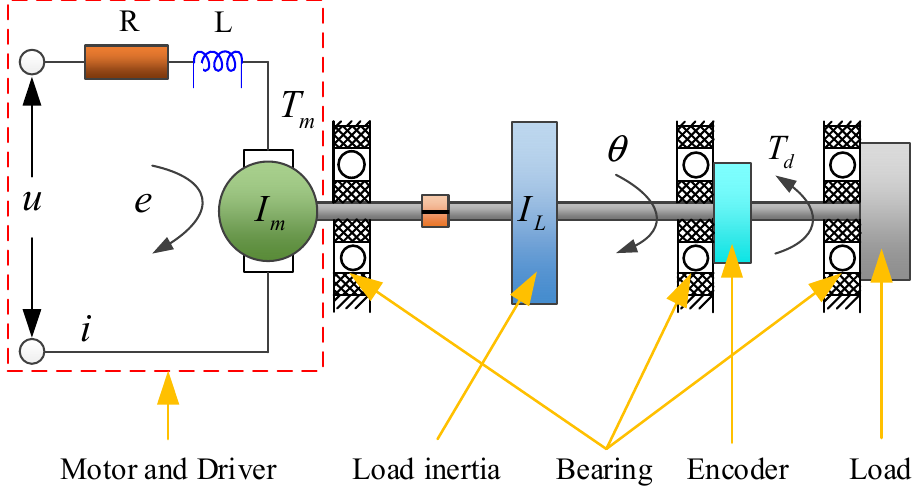
Figure 1. Schematic diagram of DDCs.